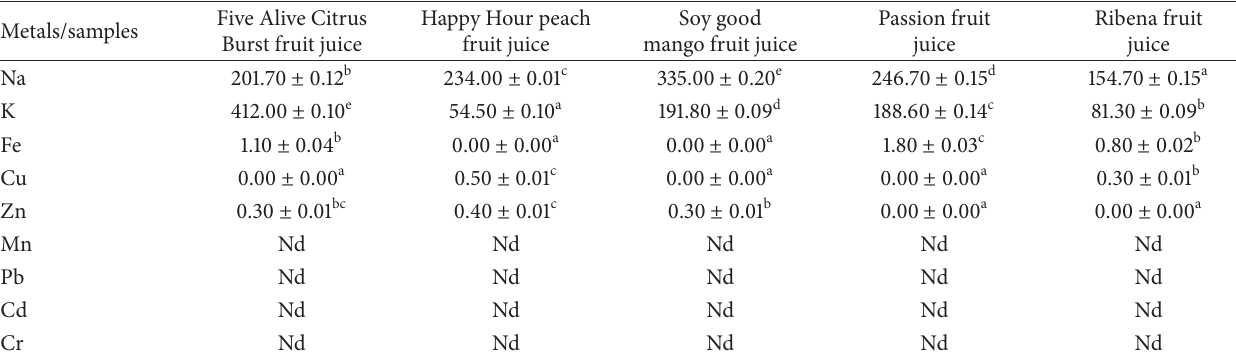
Table 2: Trace metal and mineral content in different packaged fruit juices